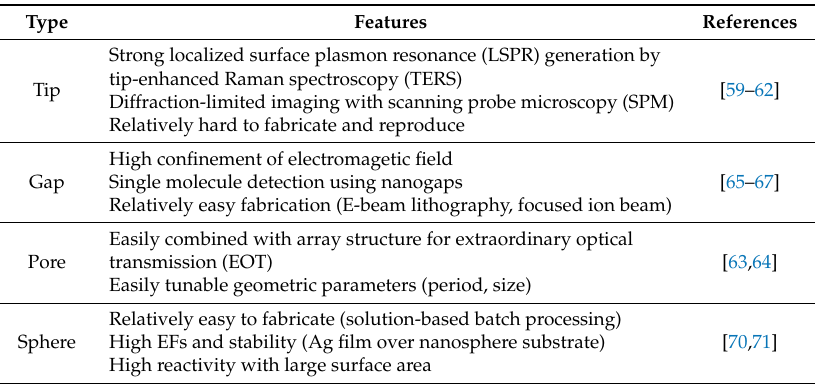
Table 1. Various types of nanostructures for SERS and their